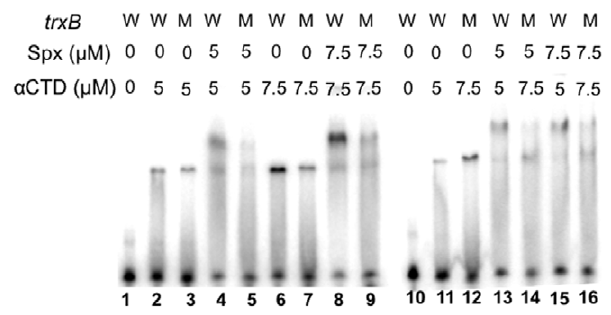
Figure 8. Effect of trxB base substitutions on interaction with a CTD and Spx. The wild-type (W) and the trxB (G-44A/G-33A) mutant (M) probes were incubated with different concentrations of a CTD and Spx as described in Figure